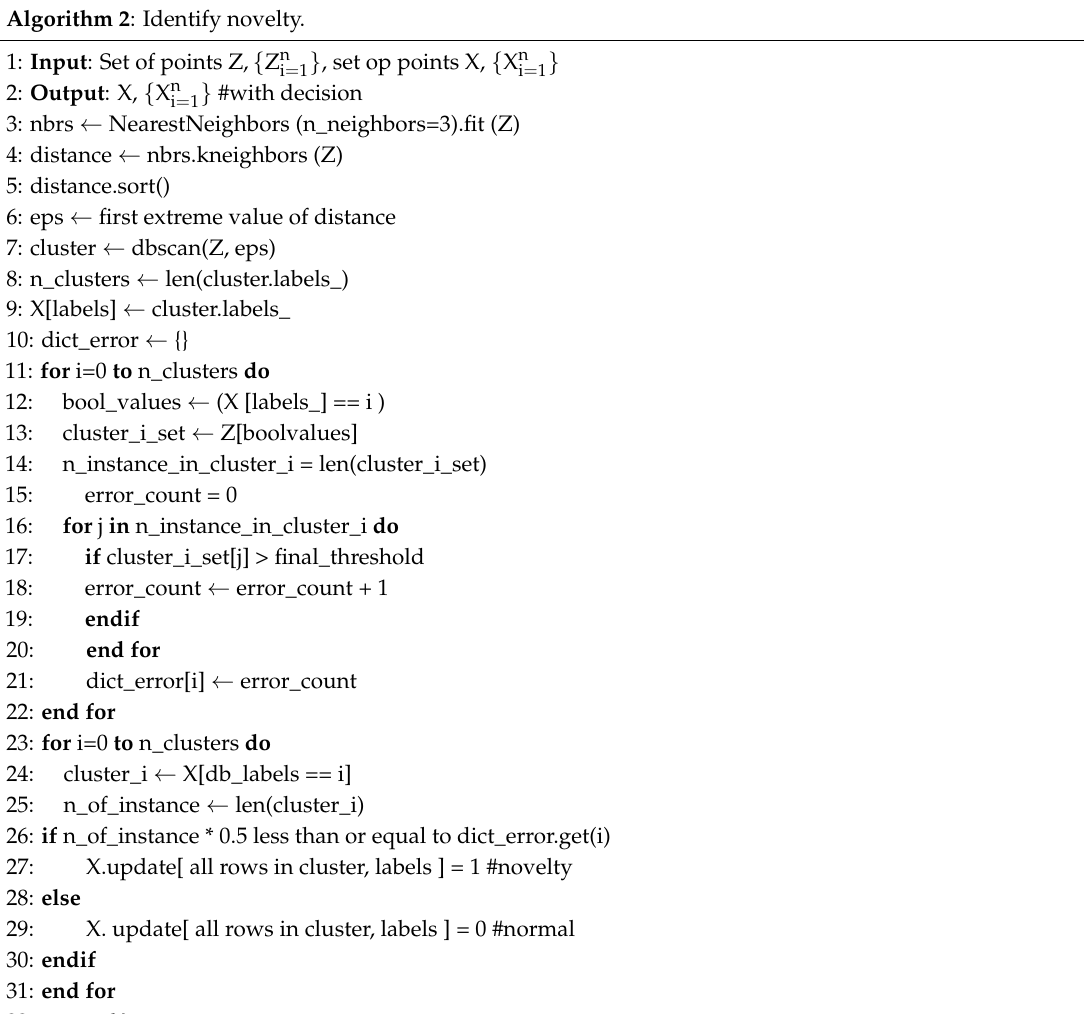
Algorithm 2’s computational complexity is defined